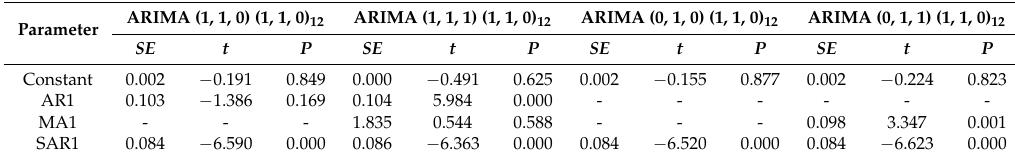
Table 3. Parameter estimation for available autoregressive integrated moving average (ARIMA) models for the prediction of